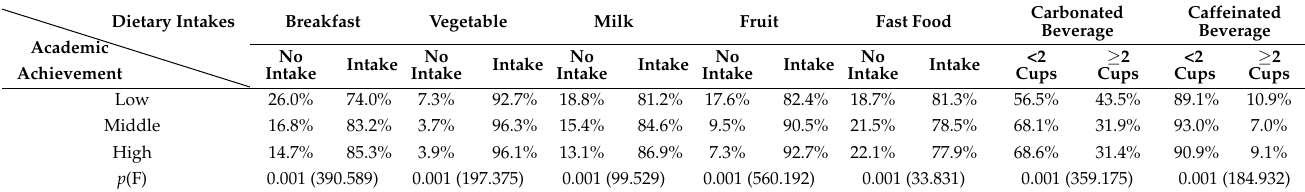
Table 7. Associations of dietary intake with the level of academic achievement.